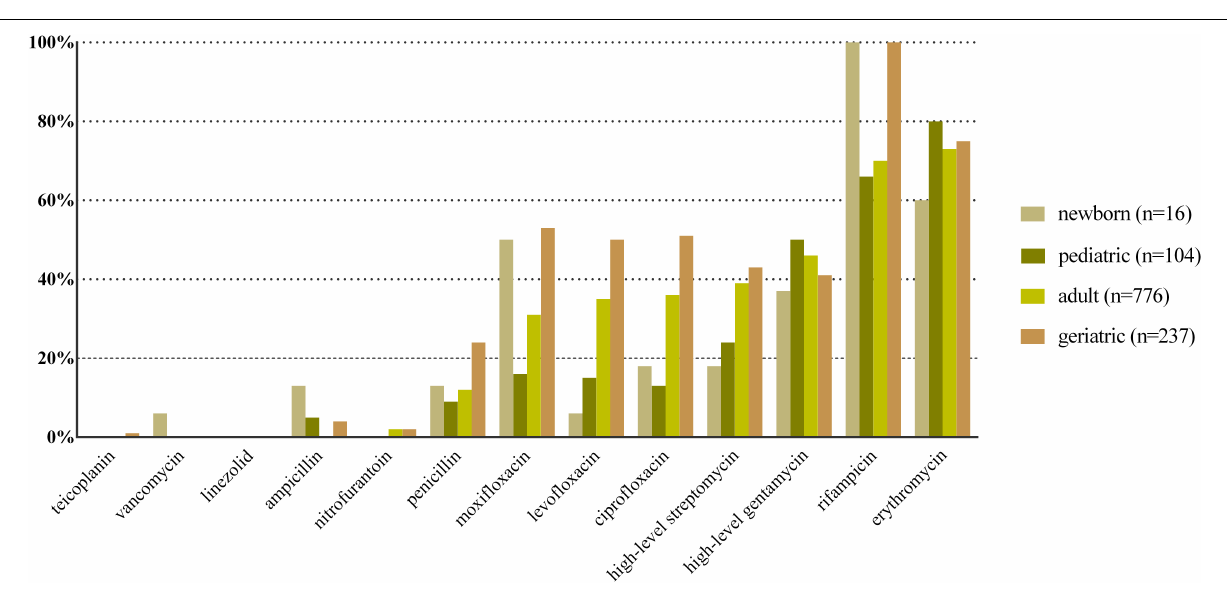
FIGURE 4 | Antibacterial resistance rates of urinary E. faecalis in different age categories. X -axis: different antibiotics tested for urinary E. faecalis , Y -axis: Antibiotic resistance